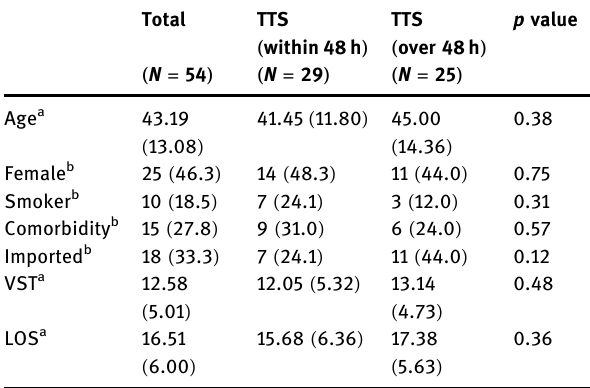
Table 1: Descriptive analysis of cases with COVID - 19